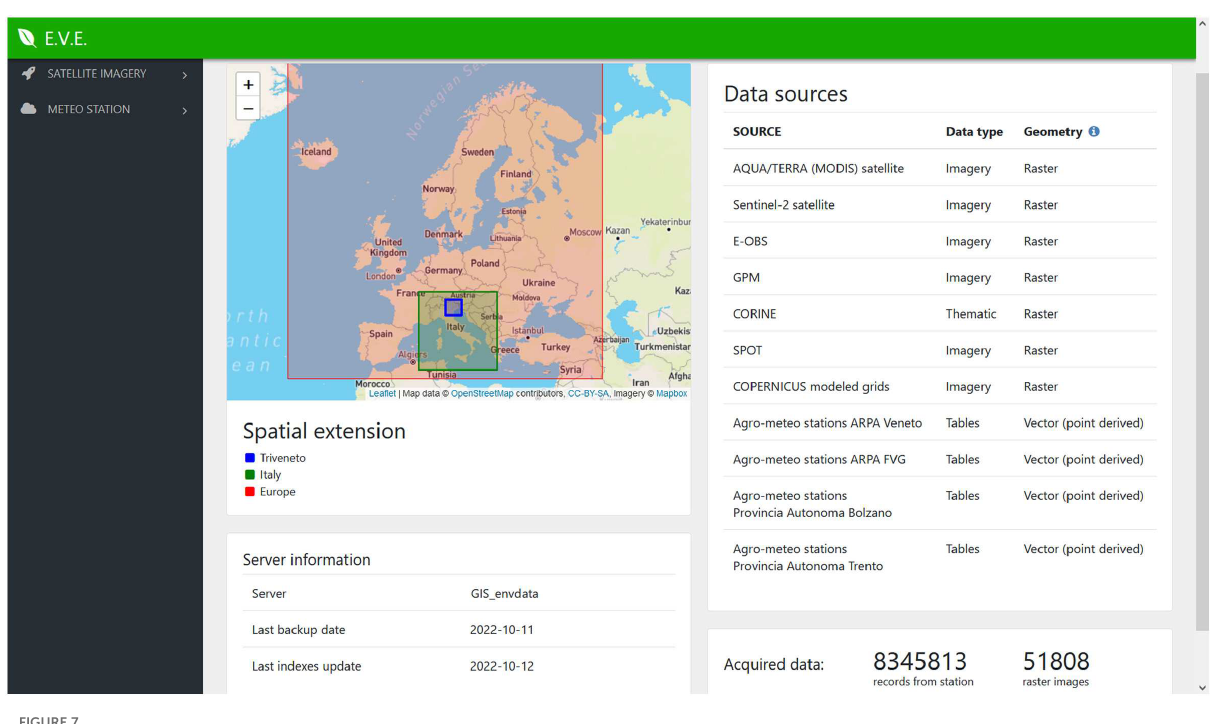
can be rapidly performed exploiting the naming convention, which allows users to search for images by variable type, extent, date and (in the case of LST) hour. However, the spatial resolution of the outputs is proportional to the scale of work (the larger the scale, the finer the details). Therefore, researchers are restricted to an aprioristic dataset, as it is not recommended to mix data at different scales, without first further processing. In fact, for some of the variables different data sources are used to produce final dataset at various geographic levels (e.g., rainfall on a local scale is obtained from local meteo-stations, while on a continental scale from GPM mission), hence, possible inconsistencies night arise when different geographic levels are